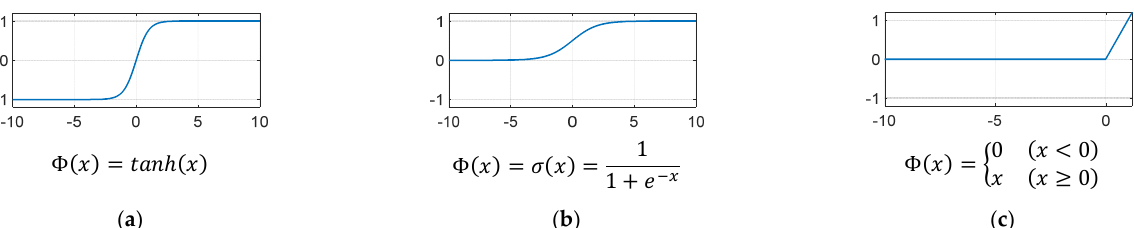
Figure 4. Structure of a perceptron.